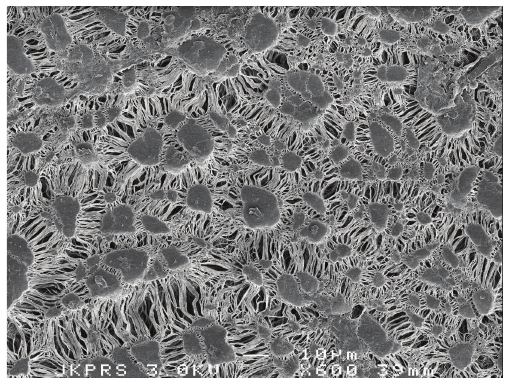
Figure 1: Expanded PTFE provides a rough surface, yet low adhe- sion of platelets.